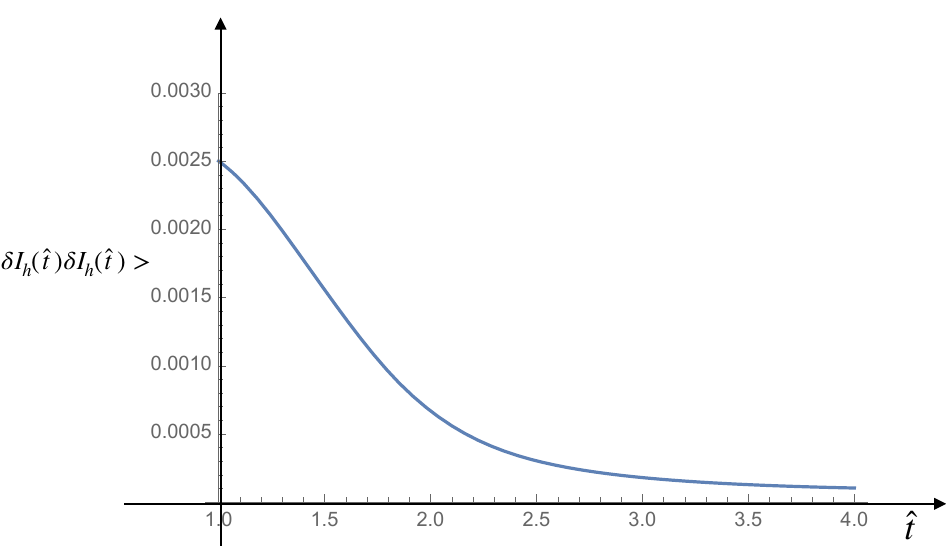
Figure 18. Correlation function < ( δ I h ( t )) 2 > for Italy, first wave of infection by SARS-CoV-2. This correlation function is the solution of the second equation of system (61). Having chosen our reference state I hRS = C h , we get a typical correlation function for random fluctuations at